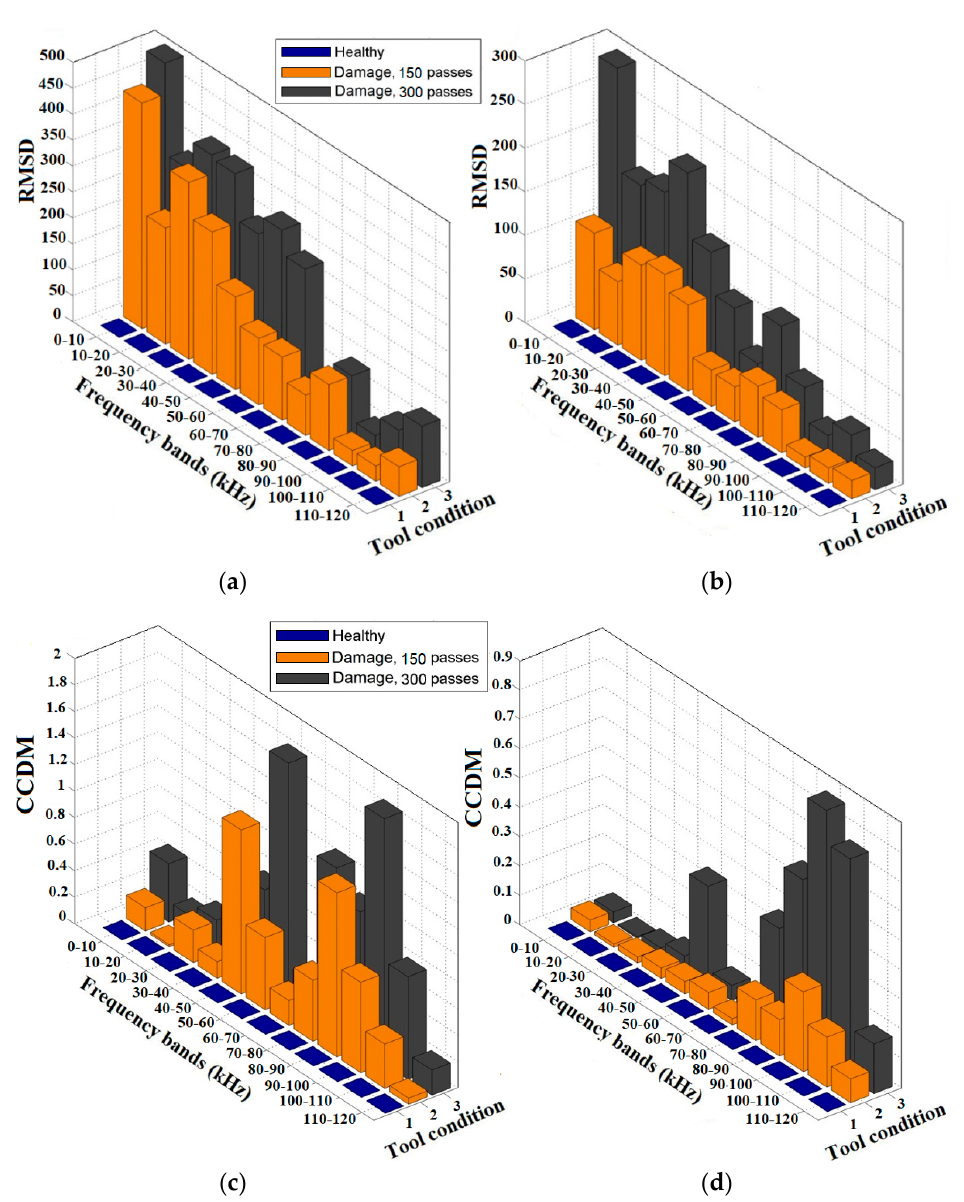
Figure 7. Damage indices results of the natural diamond-dressing tool: ( a ) RMSD of PZT1; ( b ) RMSD of PZT2; ( c ) CCDM of PZT1; and ( d ) CCDM of PZT2.